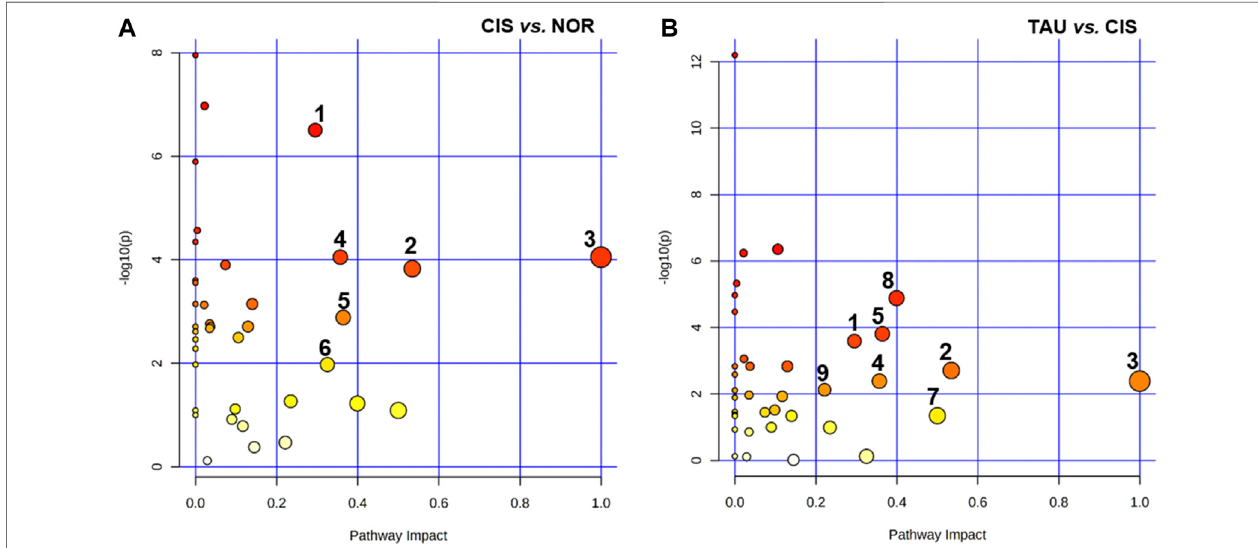
FIGURE8| Signi fi cantlyalteredmetabolicpathwaysidenti fi edfrompairwisecomparisonsofCISvs.NORandTAUvs.CIS.Thesigni fi cantpathwayswereidenti fi ed with pathway impact values > 0.2 and p values < 0.05, using the Pathway Analysis module provided by MetaboAnalyst 4.0 webserver. Numbers in the panels represent signi fi cantlyaltered metabolic pathways: (1)glycine,serine,and threonine metabolism; (2)alanine,aspartate,and glutamate metabolism; (3)phenylalanine,tyrosine, and tryptophan biosynthesis; (4) phenylalanine metabolism; (5) glutathione metabolism; (6) starch and sucrose metabolism; (7) D-glutamine and D-glutamate metabolism; (8) β -alanine metabolism; and (9) histidine metabolism.